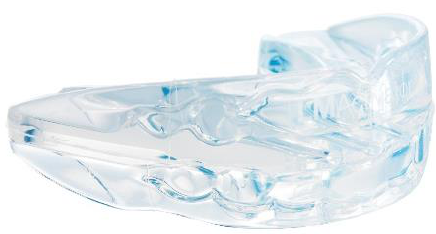
Figure 4. LM-Activator High Short (LM-Instruments Oy, Parainen, Finland).